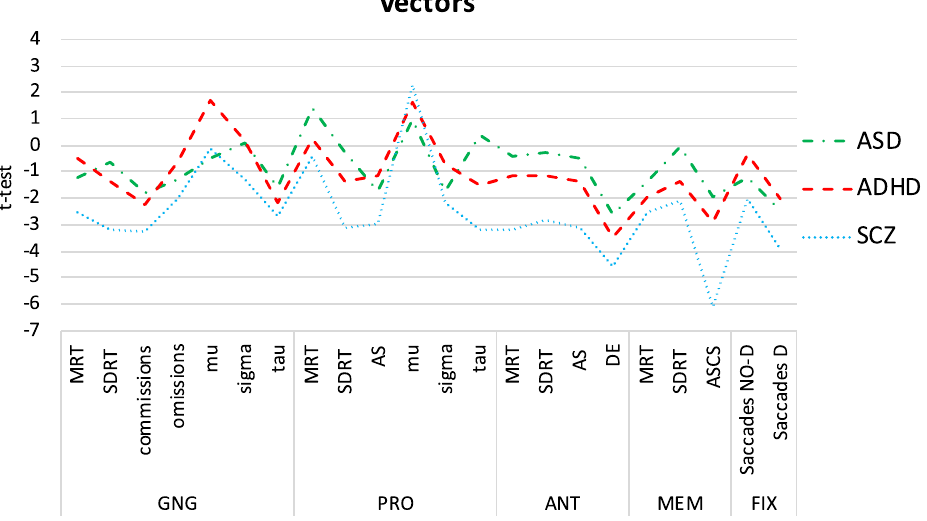
Figure 4. Vectors of deviancy from controls based on multiple comparisons of each clinical group versus TD on all dependent variables. * SD standard deviation, * AS anticipatory saccades, * Saccades No‑D FIX block without distractors, * Saccades D FIX block with